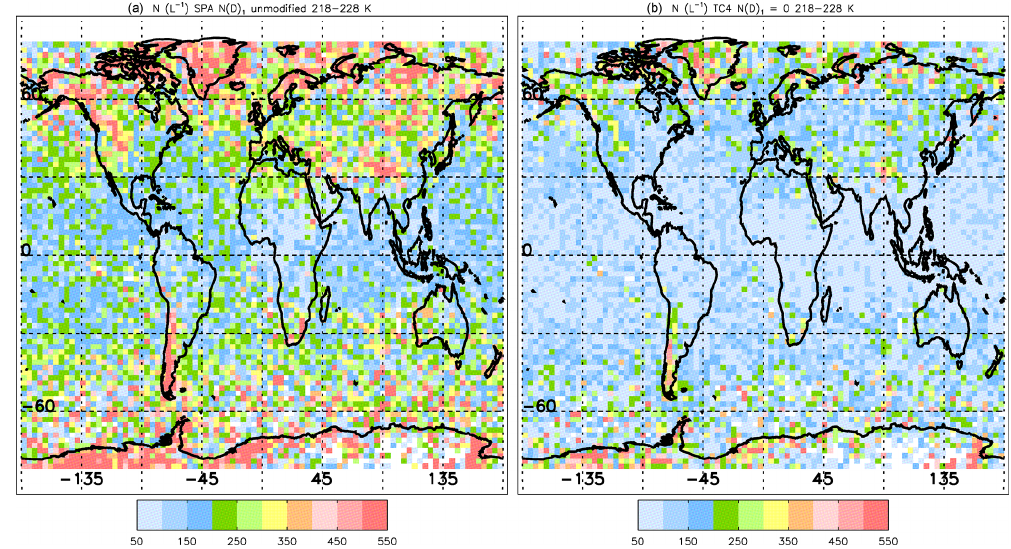
Figure 12. Geographical distribution of median ice-particle number concentration N (L − 1 ) during 2008 and 2013, where the layer repre- sentative temperature, T c , is between 218 and 228K. The retrievals use the following two formulations: SPARTICUS N(D) 1 unmodified (a) and TC4 N(D) 1 = 0 (b)